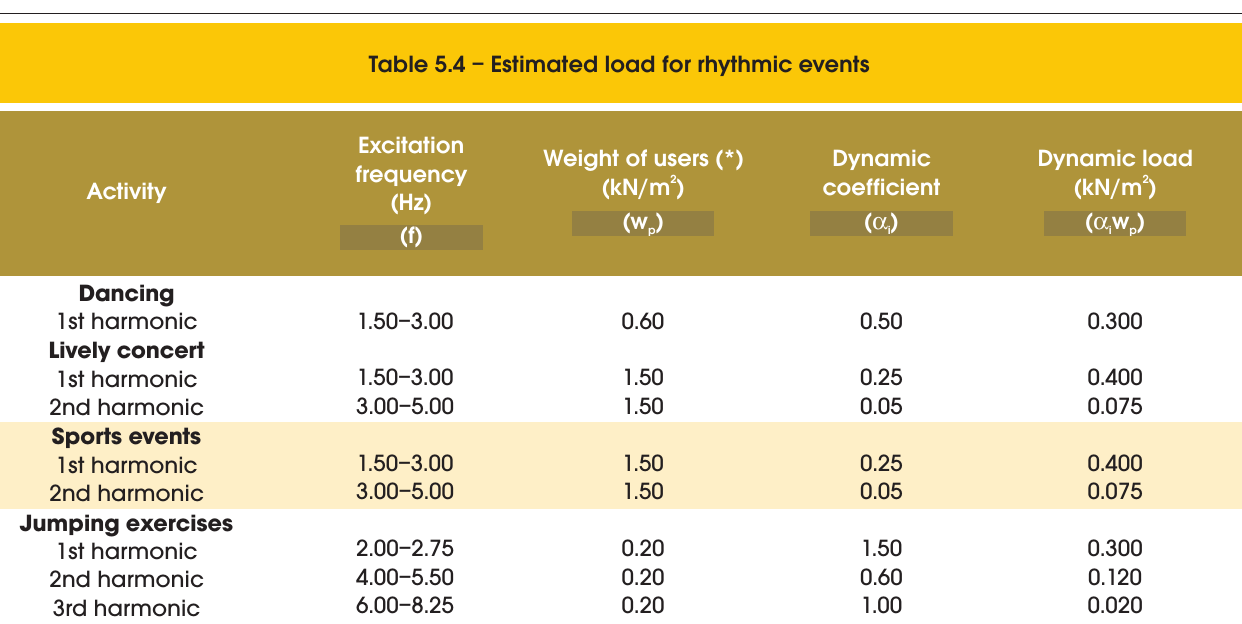
Table 5.4 – Estimated load for rhythmic